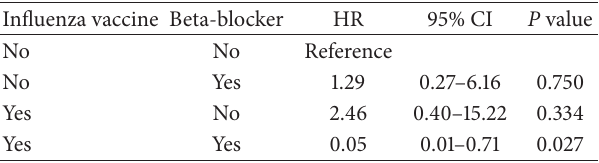
Table 5: Multivariable hazard ratios and 95% confidence intervals of influenza vaccination and beta-blocker for hospitalization due to HF. Influenza vaccine